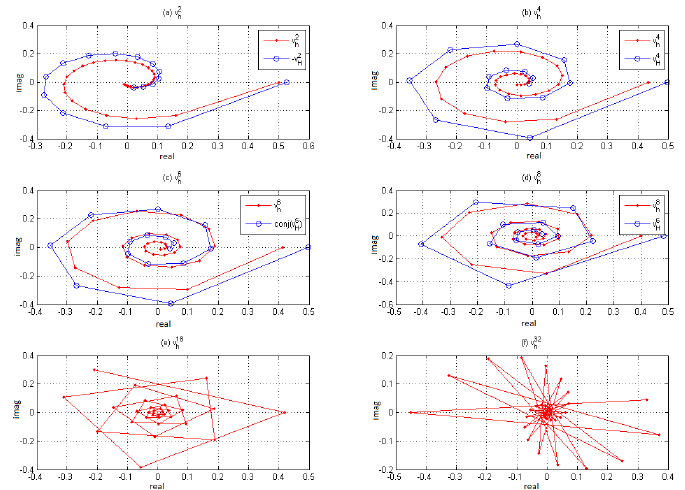
Figure 7. GS: The eigenvectors v i with i = 2 , 4 , 6 , 8 , 18 , 32 are given in red dots in the h complex plane, h denotes the fine grid 32 × 1. The blue circles shows the corresponding eigenvectors of GS on coarser 16 × 1